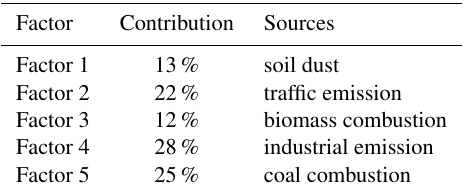
Table 2. Sources identified by NMF